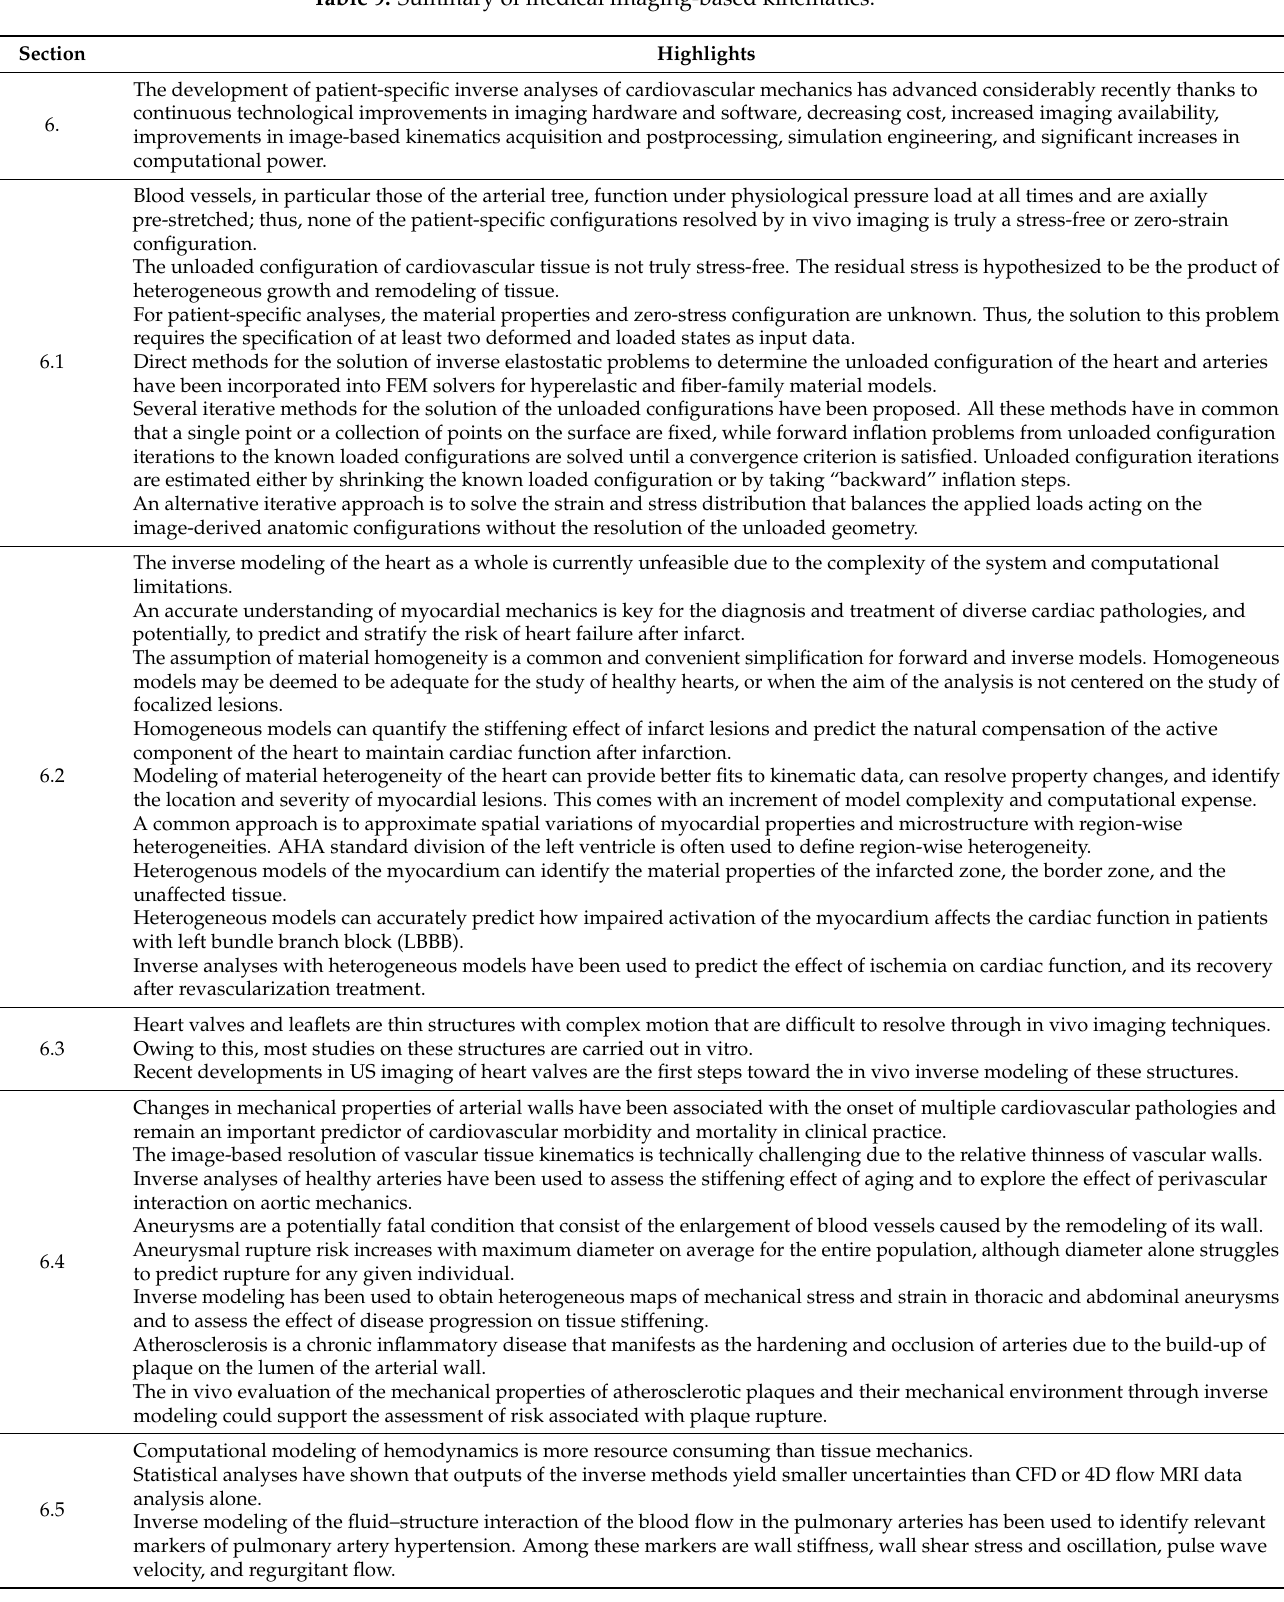
Table 9. Summary of medical imaging-based